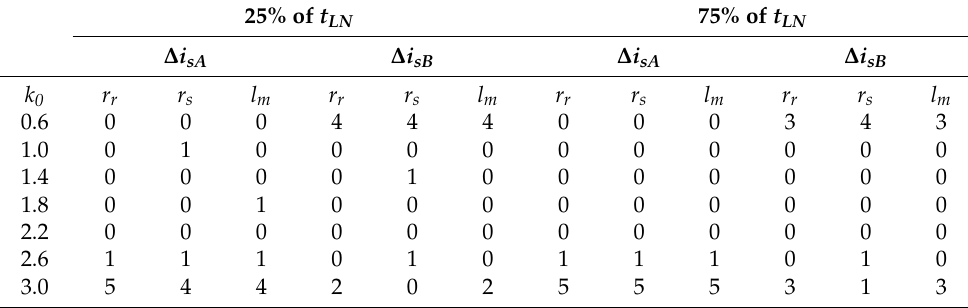
Table 5. The number of smallest RMSE values for individual k 0